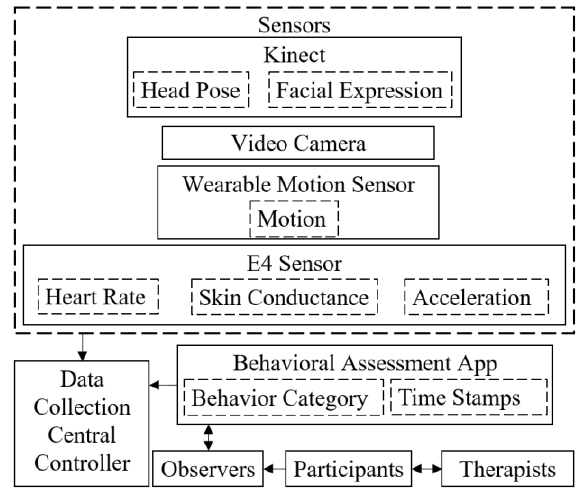
Figure 2. Platform architecture. Figure 2. Platform